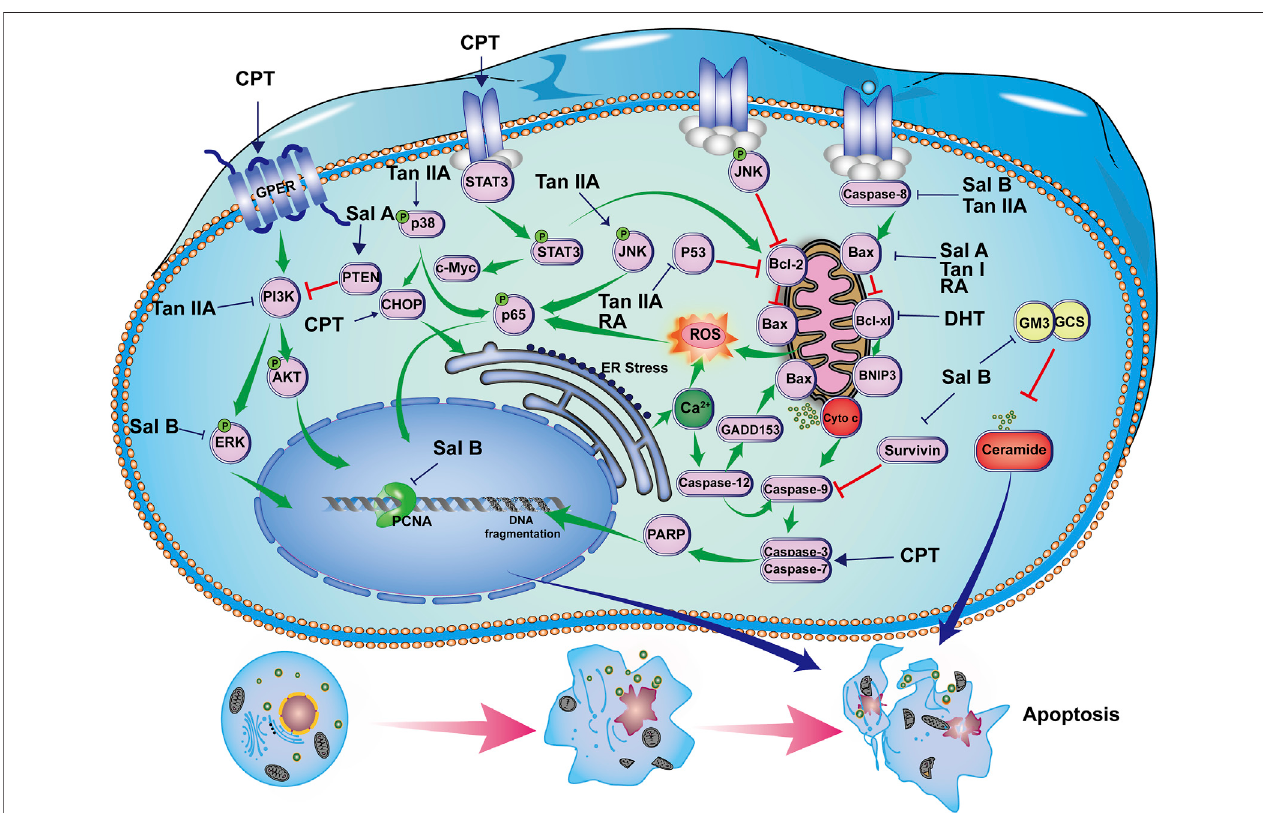
FIGURE 2 | Induction of apoptosis by bioactive constituents of S. miltiorrhiza. CPT induces apoptosis through GPER/PI3K/Akt and STAT3 activation, c-Myc and Bcl-2 inhibition, PARP and Caspase-3 cleavage, and CHOP-mediated endoplasmic reticulum stress. DHT induces apoptosis through inhibiting Bcl-xl, promoting cytochrome C release, activating Caspase-3, Caspase-7, and Caspase-9 cleavage. Tan I inhibits Bcl-2,increases Bax, and Caspase-3 expression. Tan IIA induces apoptosis by inhibiting p53, p-ERK, Bcl-2, and PI3K/Akt pathway and increasing Bax, Caspase-3, p-p38, p-JNK expression, and CHOP-related endoplasmic reticulumstress.SalAinhibitsBcl-2andp-Akt,promotesPTENandBaxexpression,andmeanwhileinducesCaspase-3,Caspase-9,andPARPcleavage.SalBinhibits Bcl-2, Bcl-xl, Survivin, and p-ERK expression, promotes Caspase-3, Caspase-8, and Caspase-9 activation, while it inhibits glucosylceramide and GM3 synthase expression, inducing ceramide-mediated apoptosis in breast cancer cells. RA induces apoptosis through down-regulating BNIP3 and Bcl2/Bax ratio and up-regulating P53, and caspase-3